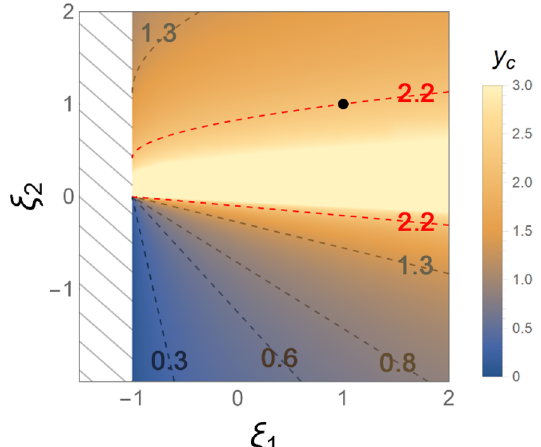
Figure 1 . Bounds on (4-Q) operators coefficients for N f = 2 . Plot showing the allowed region (in color) obtained for the (4-Q) operators restricted to N = 2 with generic ξ values, as y changes. f c Every region associated to a larger y value is contained in the previous ones: for instance, blue and c dark orange regions are allowed for any y roughly smaller than 4, but forbidden for larger values of c y c . The redundant ξ 4 has been set to 0. In this case ξ 3 > 0 , and using that the bounds are invariant under a full rescaling, we have set ξ = 1 , and plot the remaining two independent coefficients. As 3 explained in the text, values of y 1 are unphysical and are only plotted for visual reasons. The c > black point represents the natural MFV benchmark point ξ = 1 . The red line contours the 1 , 2 , 3 q √ region corresponding to the threshold value of y = 2(1 + 2) : for bigger values of y , the natural c c benchmark point does not belong to the allowed region any more. The region ξ 1 is excluded 1 < − for any value of y . For the physical value y 10 − 2 , almost all points ( ξ 1 , ξ ) are c c ≈ 1 ≥ − 2